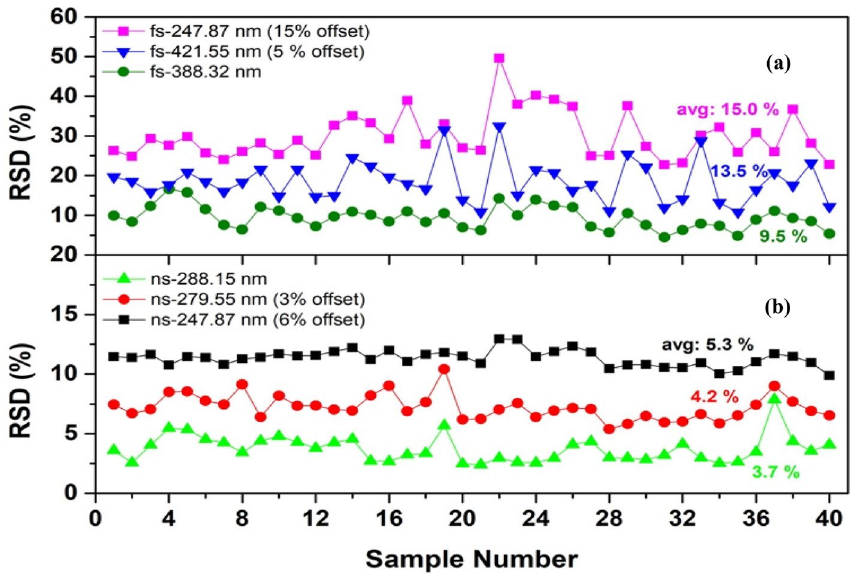
Figure 12. Relative standard deviations (RSDs) of 100 spectra for the 40 coal samples ablated by: ( a ) fs-Solstice , and ( b ) ns-Chem systems with average RSDs of 9.7% and 2.5% for the two systems respectively. Offsets are to avoid points’ overlapping for